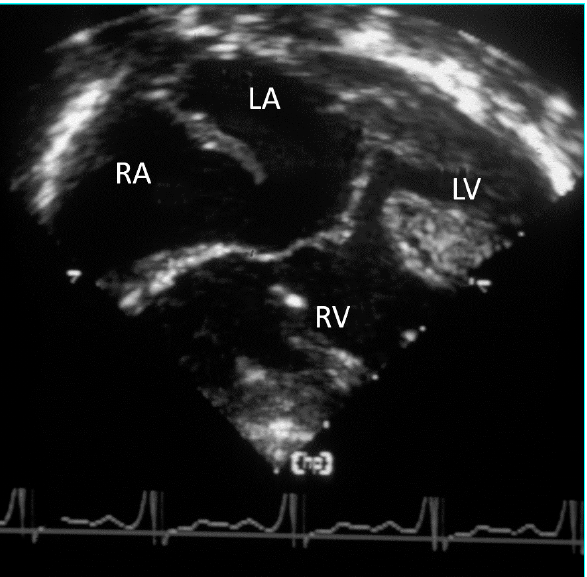
Figure 13. Echocardiographic four chamber section from a heart with complete AVSD, hypoplastic left ventricle and the morphological criteria for the double inlet right ventricle.